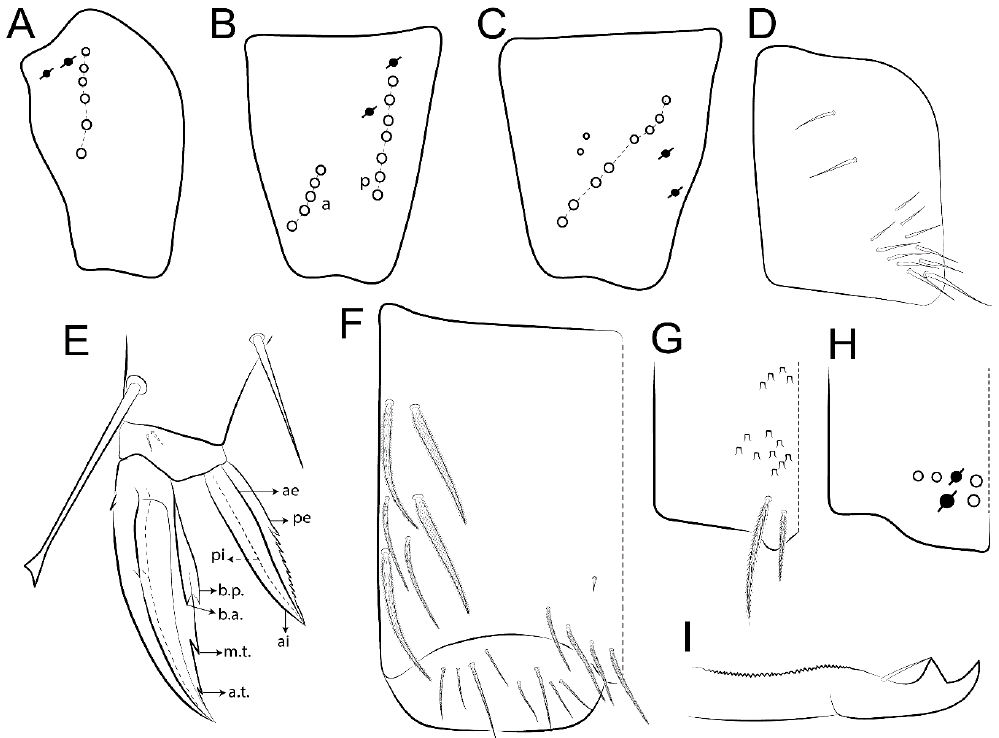
Figure 68. Pseudosinella chimerambigua sp. nov. ( A–C ) subcoxa I–III, respectively; ( D ) trochanteral organ; ( E ) distal tibiotarsus and empodial complex III (anterior view); ( F ) collophore (lateral view); ( G ) distal part of manubrium (ventral view); ( H ) manubrial plate (dorsal view); ( I ) distal dens and mucro (outer view).